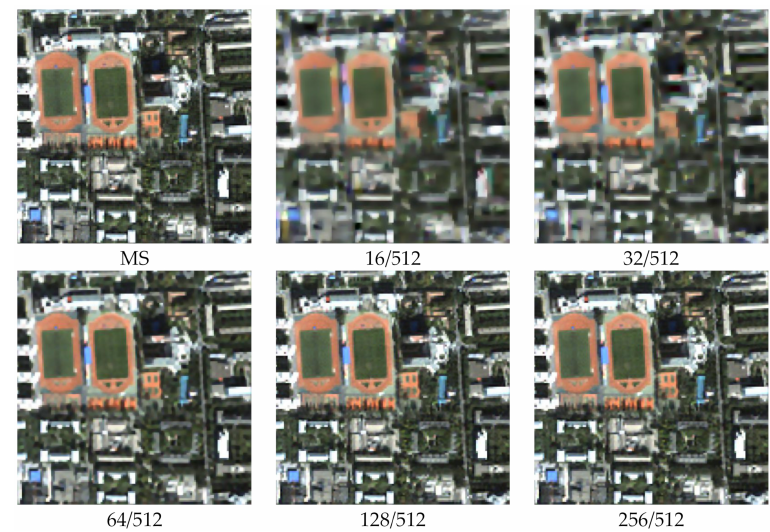
Figure 1. Cartoon components of the MS image at different scales.